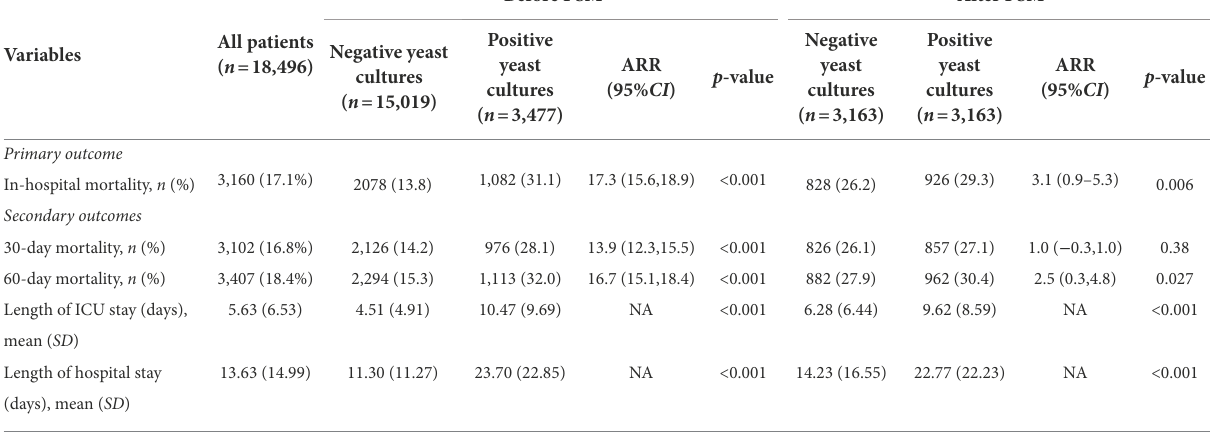
TABLE 2 Primary and Secondary outcomes before and after